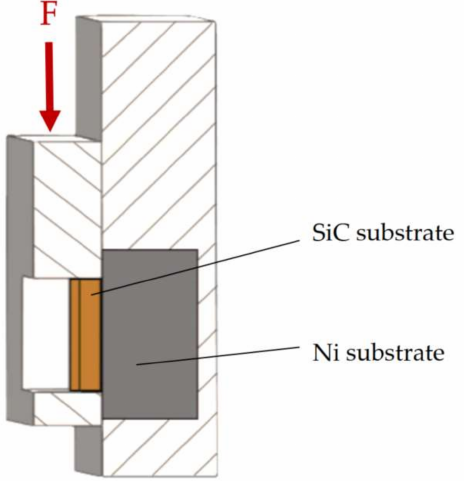
Figure 4. Scheme of shear strength measurement